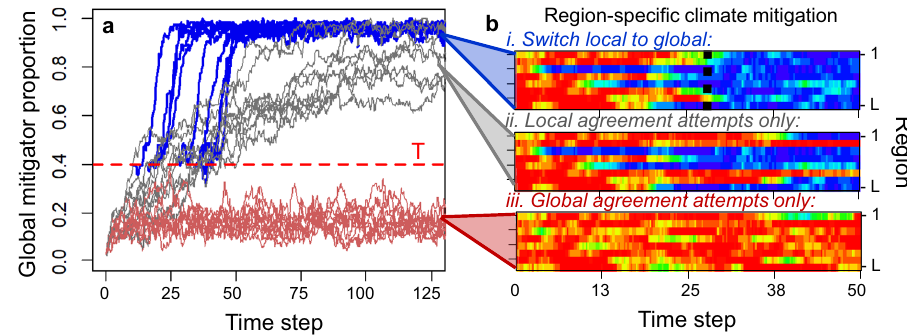
Fig. 1 Mitigation is best achieved through a timely shift from local to global agreements, on account of scale-speci fi c mechanisms. a Time series of the proportion of system-wide climate mitigation over ten replicate model runs with global agreements only (red), local agreements only (gray), or a shift from local to global agreements (blue lines) once mitigation is suf fi ciently common (threshold T = 0.4). b Proportions of mitigators from 0 (red) to 100% (blue) across regions 1 to L (y-axes) and time (x-axes) within a single model run under three approaches (i – iii). Unlike global agreements ( b .iii), local agreements are critical for establishing mitigation as the norm in early-adopting regions (e.g., region 3 in b .ii); global agreements spread mitigation across regions once it is suf fi ciently common ( b .i, dashed line denoting shift to global at T ). These simulations model equal emissions across players, so that mitigation proportions equal the proportion of all players adopting a stringent mitigation strategy. Note that for global agreements only, mitigator proportions never reach the quorum p T = 0.5 required to enact agreements and non-mitigators are never sanctioned. Simulations show eight regions with 18 players in each and no among-region rivalry or economies of scale; all other parameters values listed in Supplementary Fig. 1.